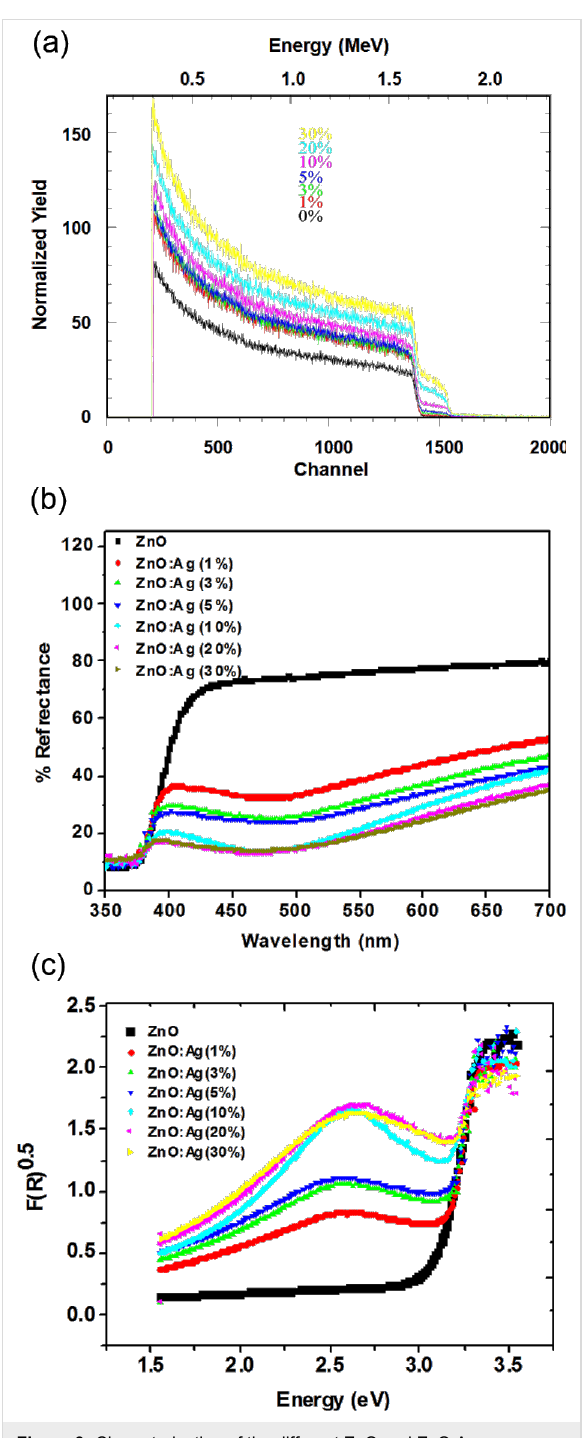
Figure 3: Characterization of the different ZnO and ZnO:Ag nanocom- posites. (a) RBS analysis; atomic composition graph is showing the relative amounts of Zn, O and silver, (b) diffused reflectance spectra, (c) band gap energies of the different nanocomposites.